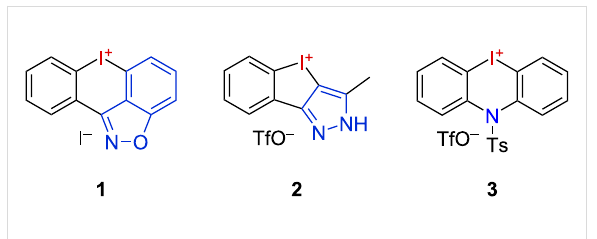
Figure 1: Nitrogen-containing iodolium and iodonium